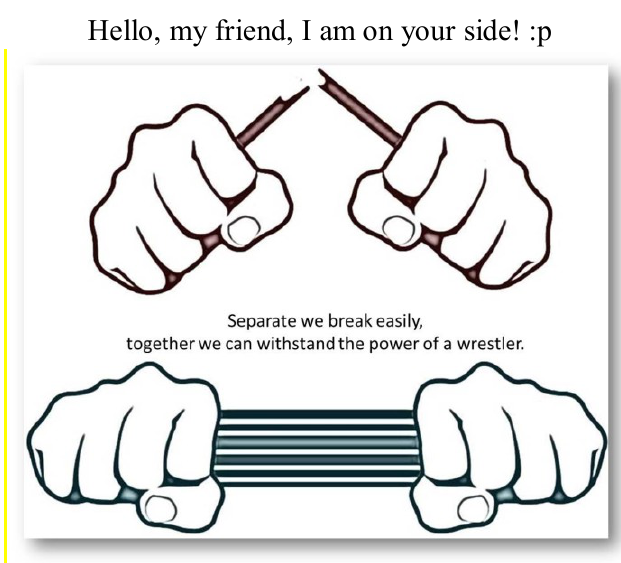
Figure 1. An illustration of positive